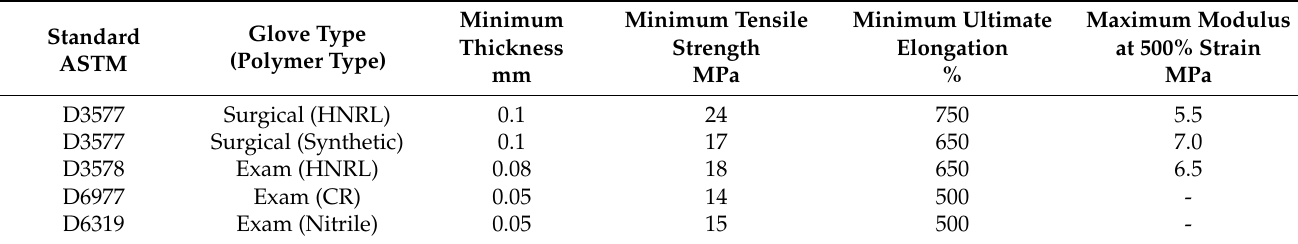
Table 7. Specifications for surgical/examination